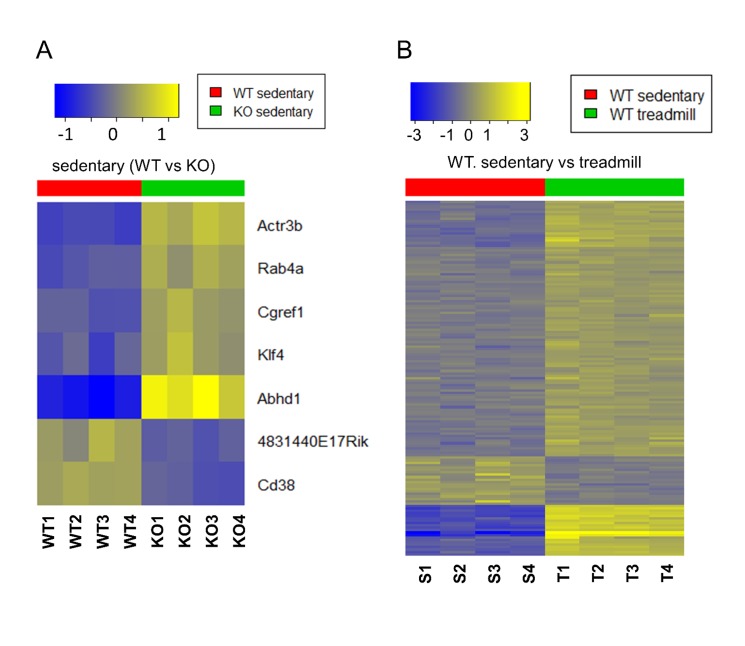
Heat maps showed differential gene expression in CD38 KO mice.(A) Heat maps of gene expression in sedentary samples from gastrocnemius comparing WT (red) and CD38 KO mice (green). Yellow denotes up-, and blue down-regulation. Genes and samples are represented by rows and columns, respectively. Genes with FDR < 0.1 and absolute fold-change > 1.5 are shown in the heat maps and are clustered by hierarchical clustering (dendrograms not shown). (B) Heat maps of gene expression comparing sedentary (red) vs. treadmill (green) in gastrocnemius of WT samples (right).